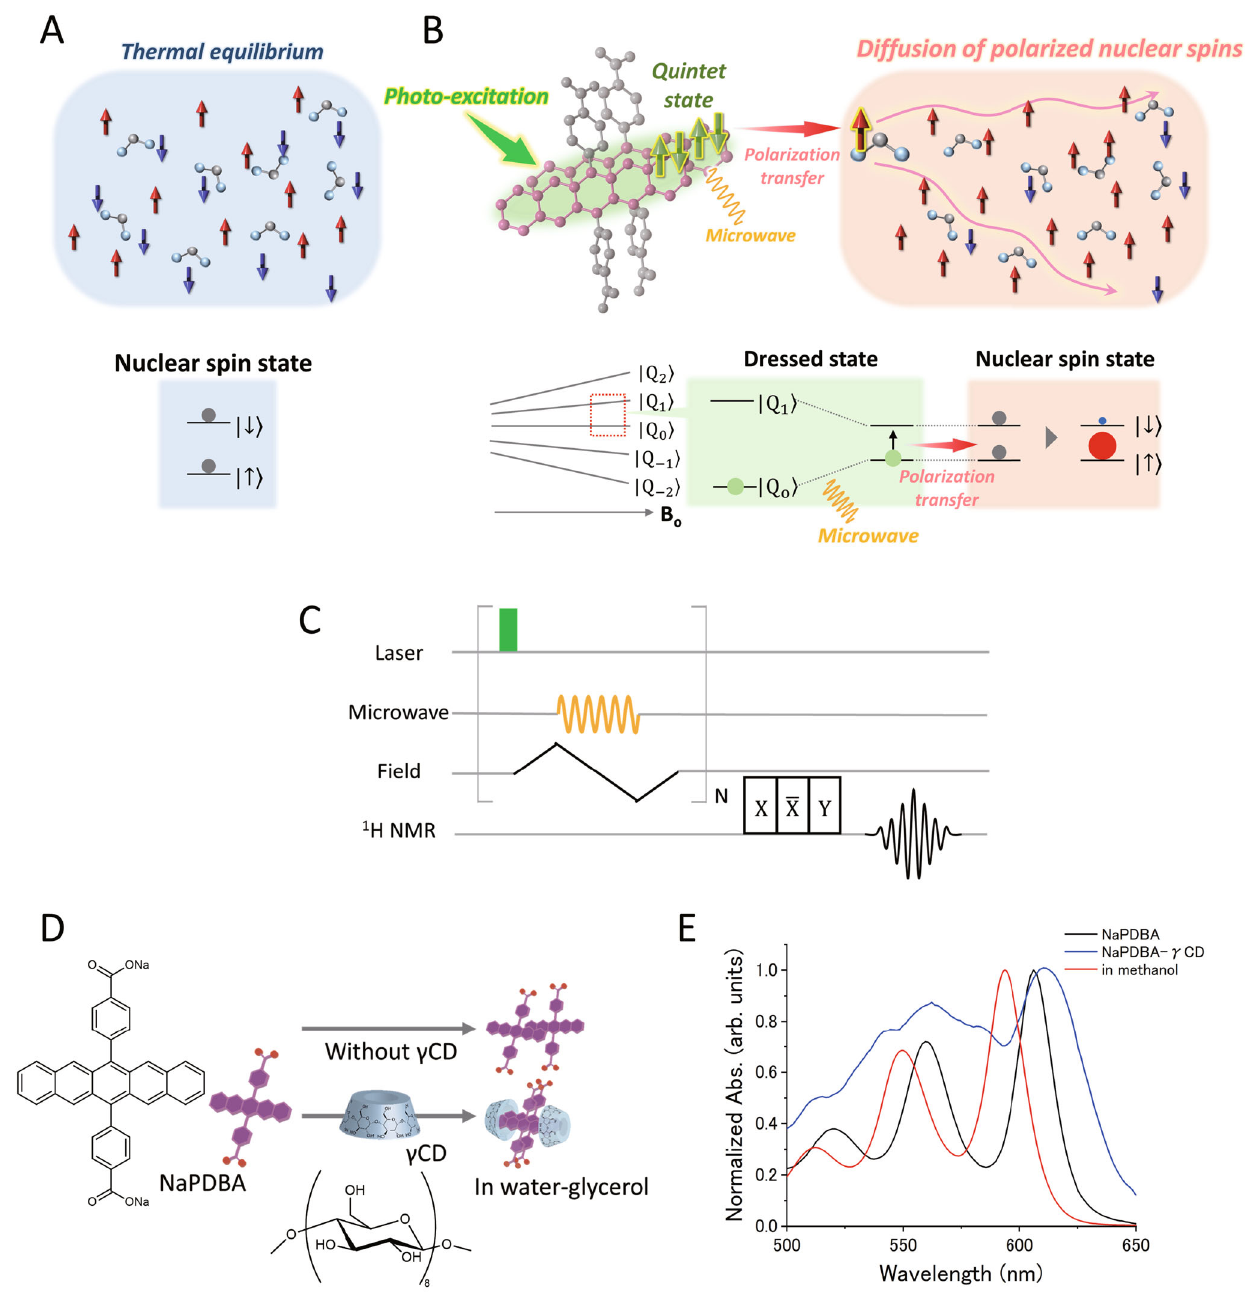
Fig. 1 | Schematic illustration of DNP using SF-born quintet electron polariza- tion. A Nuclear spins in the thermal equilibrium state. The red and blue arrows indicate α spinstate and β spin state, respectively, and the graycircles indicate the populations of each spin state. B Polarization transfer from electron spins in the quintet state (|Q 0 〉 state, green arrows) generated by photo-induced SF to nuclear spins and the subsequent diffusion of hyperpolarized nuclear spins. The green circlesindicatethepopulationsofpolarizedquintetstate.DNPincreasesthe α spin